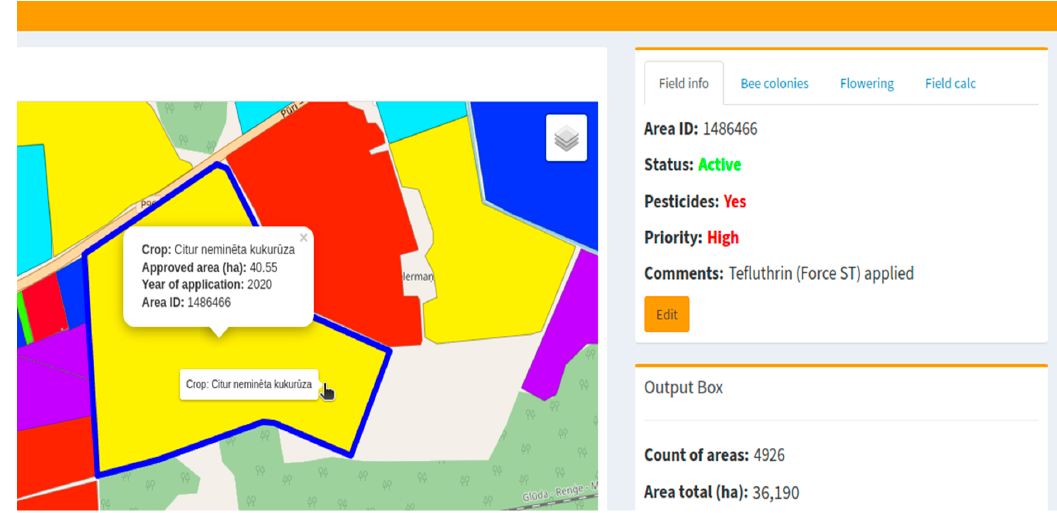
Figure 9. View mode of the field data. Different colors represent different crops.